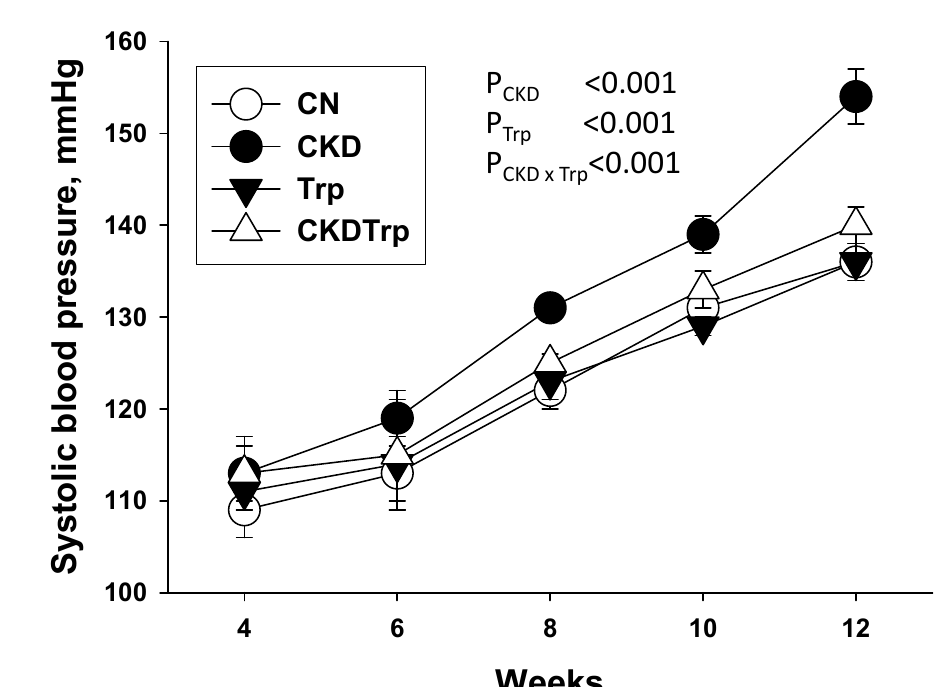
Figure 1. Effects of maternal adenine-induced chronic kidney disease (CKD) and tryptophan supplementation (Trp) on systolic blood pressure measured in male offspring at 4, 6, 8, 10, and 12 weeks of age. Data are shown as means ± S.E.M. A two-way ANOVA was performed for statistical analysis. CKD × Trp = interaction of CKD and Trp. n = 8/group.